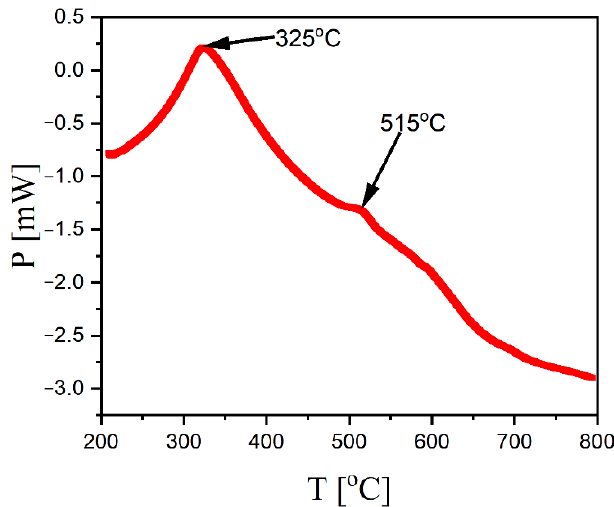
Figure 2. The DSC curve for the Ti 45 Zr 38 Fe 17 amorphous powders was obtained by MA for 40 h. The broad exothermic shoulder is visible between 200 °C and 700 °C. The energy